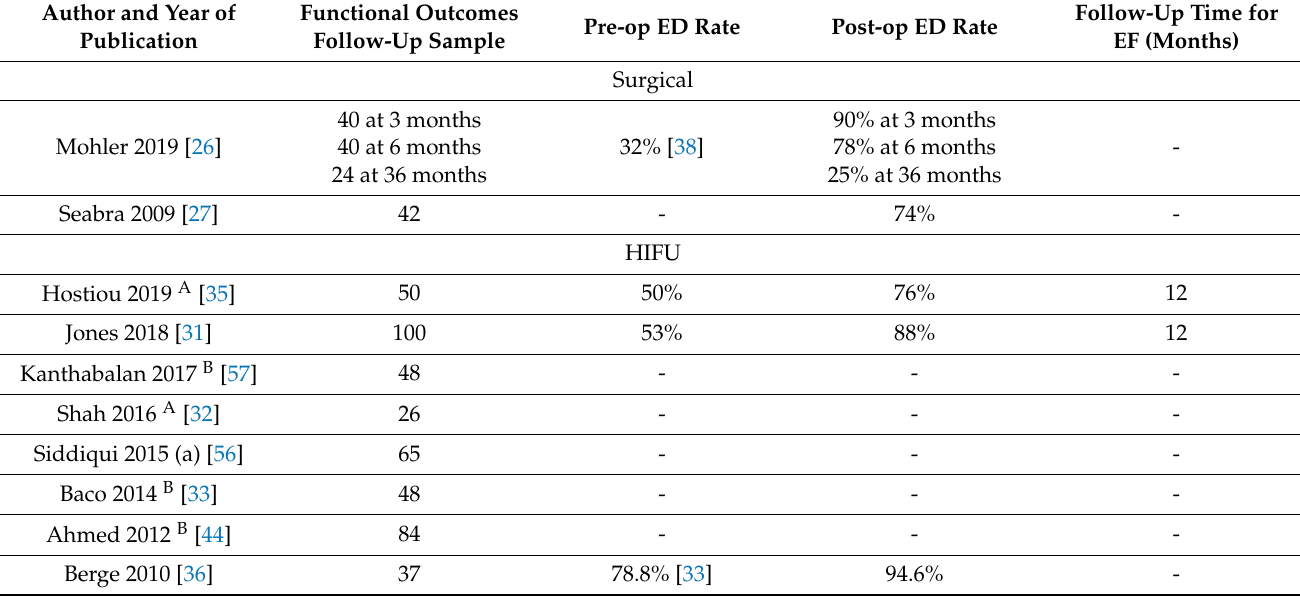
Table 3. Sexual function outcomes in patients who underwent various salvage